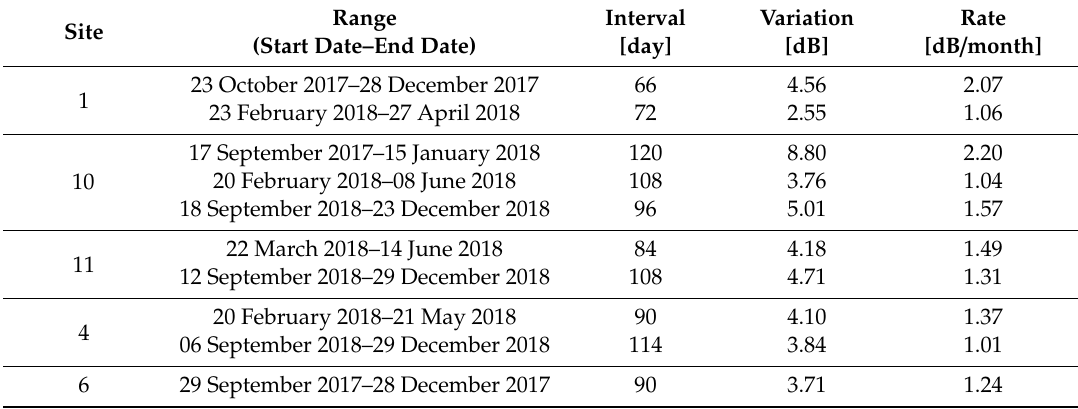
Table 3. Monthly rate of increase of VV polarized backscattering coe ffi cient σ 0 during dry periods. Site